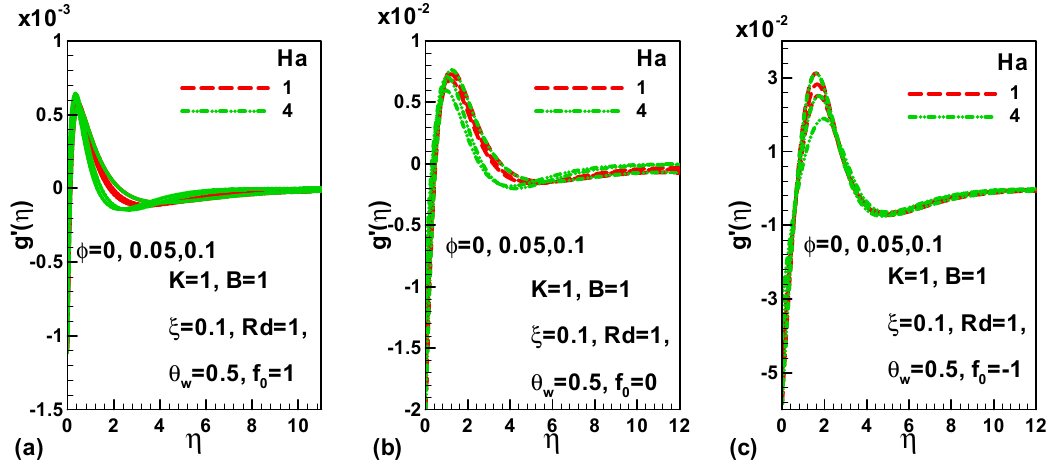
Figure 7. Effects of magnetic parameter and solid volume fraction of nanoparticles on dimensionless rotating velocity along truncated cone for ( a ) suction, ( b ) impermeable, and ( c ) injection of kerosene-based magnetite nanofluid.